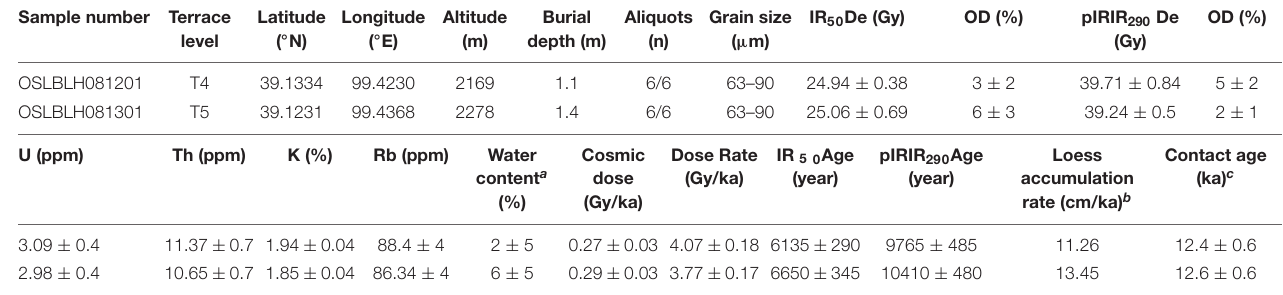
FIGURE 5 | (A) Terrace heights relative to the T3 surface showing the deformation geometry of across the Dahe Anticline. The lower part showing the fault geometry deduced from the deformed terraces with the calculating method in (B) . (B) The geometric method to calculate the subsurface fault geometry and to calculate the fault slip rate. R = radius of the curve, α = the tilt angle of the terrace surface, W = the width of the backlimb, θ = dip angle of the back thrust at the upper-most part, d = the depth to the decollement, y = the height from the surface to the center of rotation, S = the slip amount along the back thrust, h = terrace height at the anticline crest. (C) The illustration to show the area-mass-balance method to calculate the fault slip. X is the shortening area on a horizonal fault, and it equals to the uplifted area from the backlimb of the terrace surface. TABLE 1 | OSL samples from the overlying loess and dating